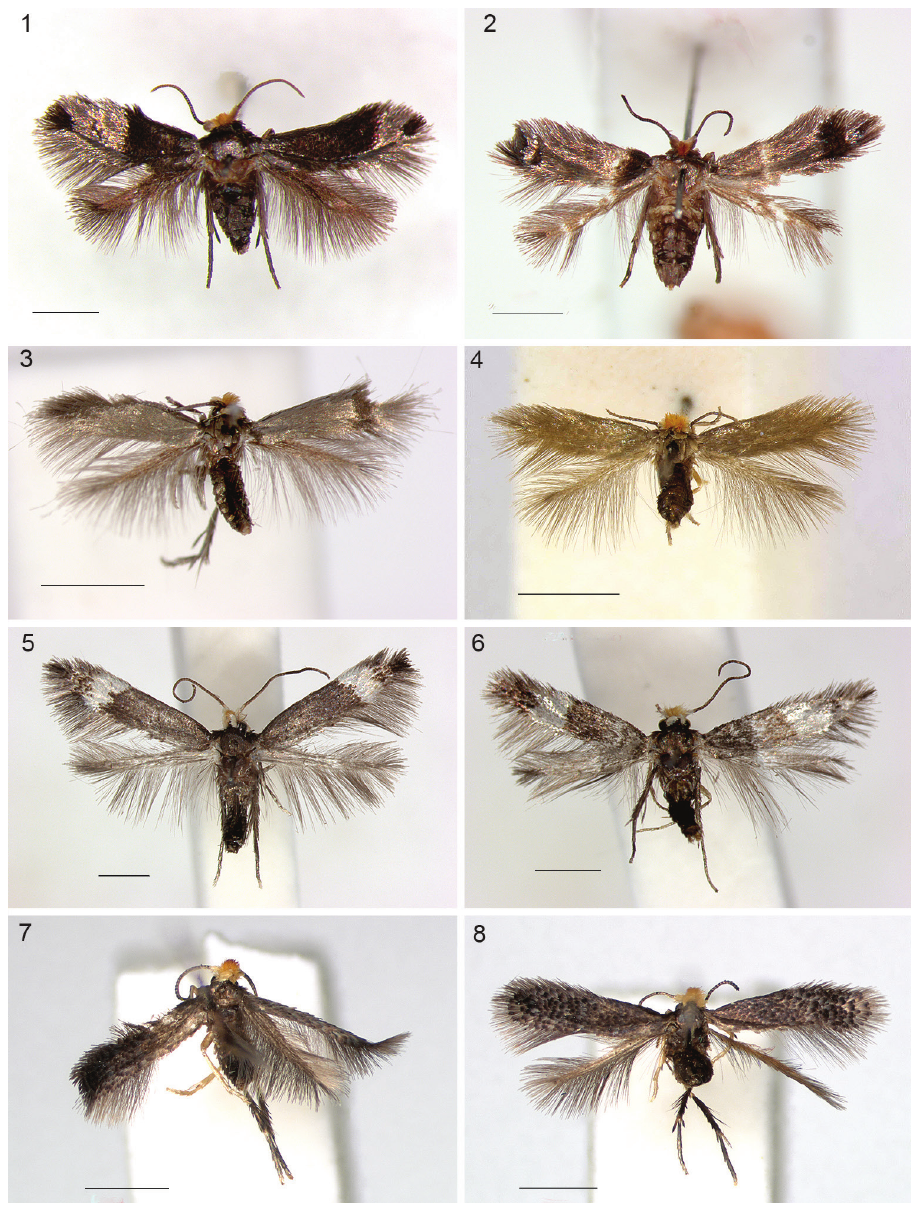
Figures 1–8. Stigmella species, adult habitus. 1 S. gallicola , male holotype 2 S. gallicola , female Here- dia Province, Puerto Viejo de Sarapiquí 3 S. schinivora , male holotype 4 S. schinivora , female RMNH. INS.24681 5 S. costaricensis , male holotype 6 S. intronia , male holotype 7 S. molinensis , male holotype 8 S. molinensis , female RMNH.INS.24219. Scale bars: 1